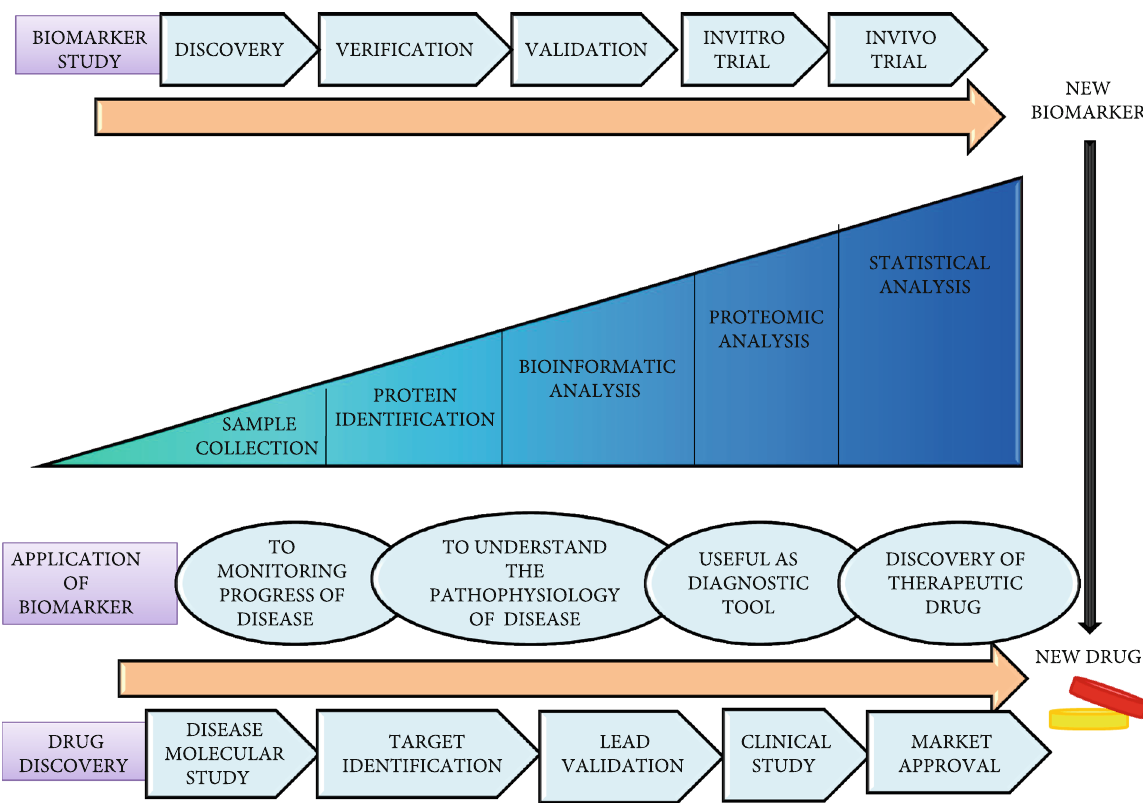
Figure 1: Biomarkers in drug discovery and development by using the proteomic